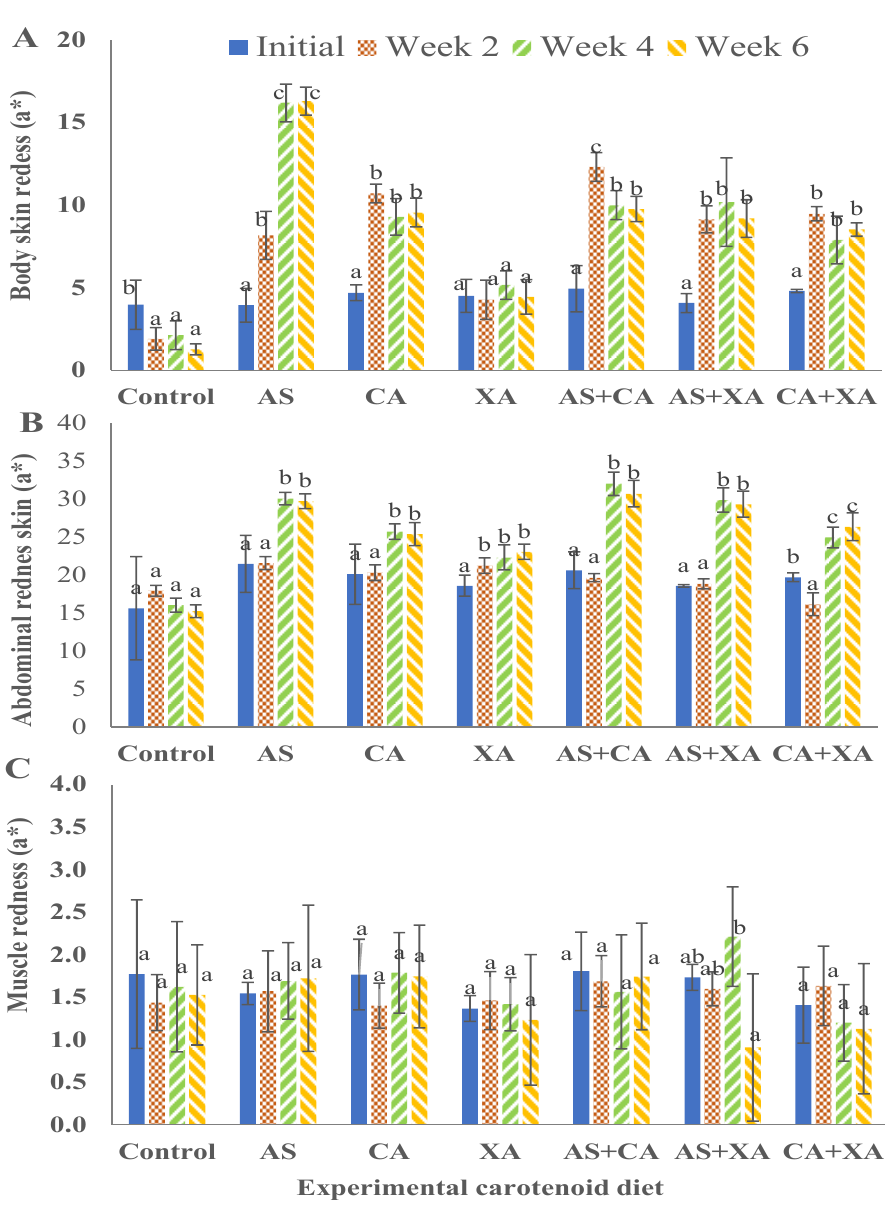
Figure 5. Redness for body skin ( A ), abdominal skin ( B ), and muscle ( C ) of bighead catfish fed dietary pigments for 2, 4, and 6 weeks. Astaxanthin (As), canthaxanthin (Ca), and xanthophyll (Xa). (a, b, c) Average values of different diets at the same sampling time with different letters are significantly different ( p < 0.05). Each bar is the mean value of three replicates, three fish per replicate.